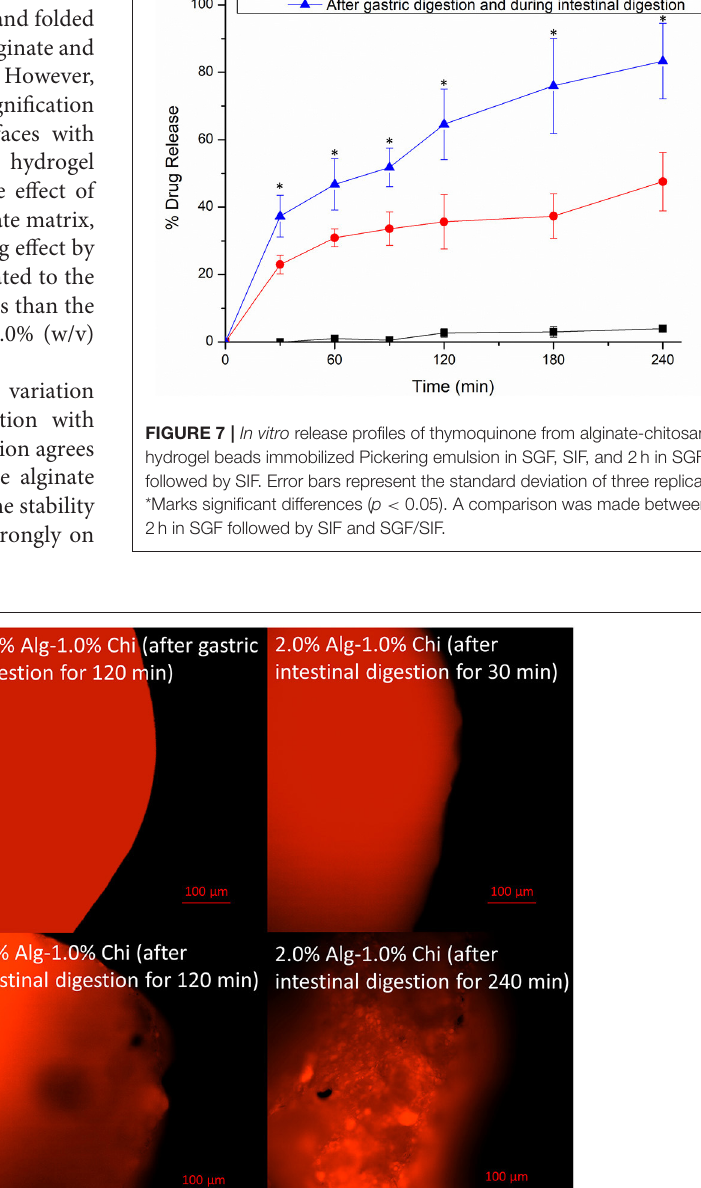
Frontiers in Nutrition |